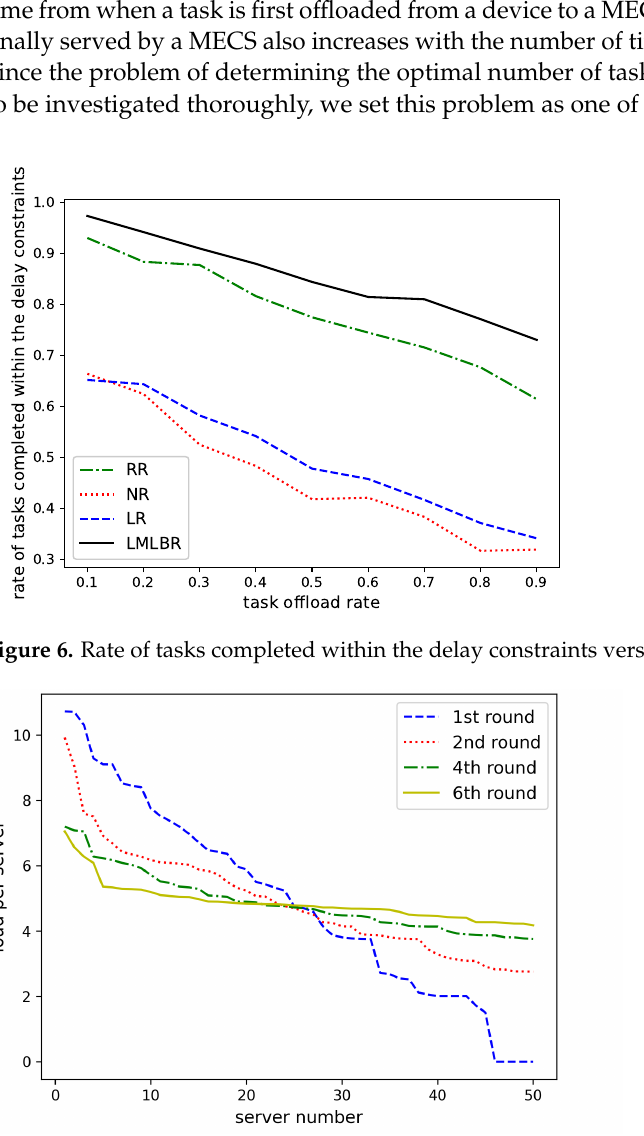
Figure 7. Influence of the number of redirect per task on the load distribution among MECSs when λ =